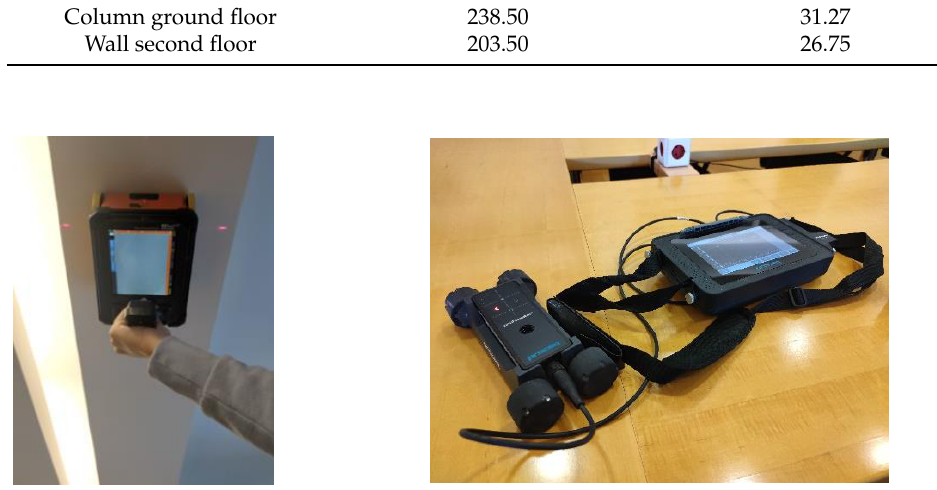
Figure 11. GPR and Profometer used for measurements